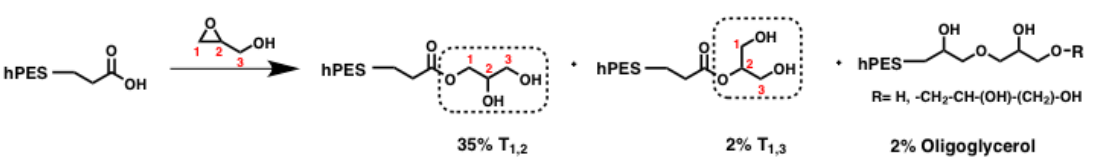
Figure 3. Extract of an IG 13 C NMR spectrum of hPES-OH 2 that is crucial for evaluation of DB and shows the assignment of methine C H and methylene C H2 signals of various glycerol